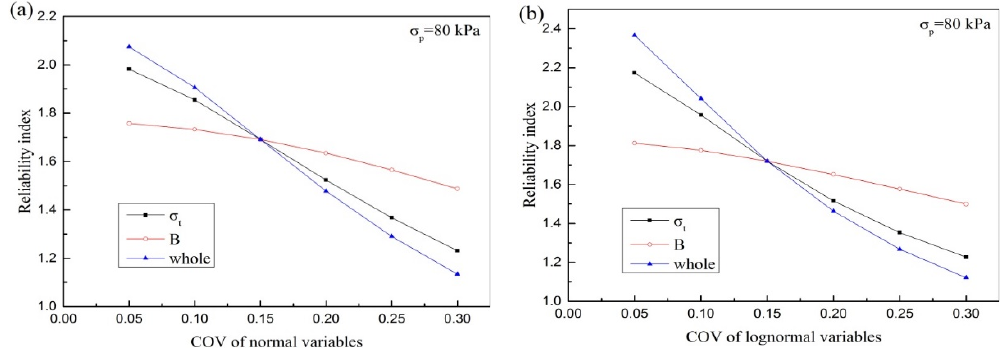
Figure 5. Influence of coefficient of variation on reliability.